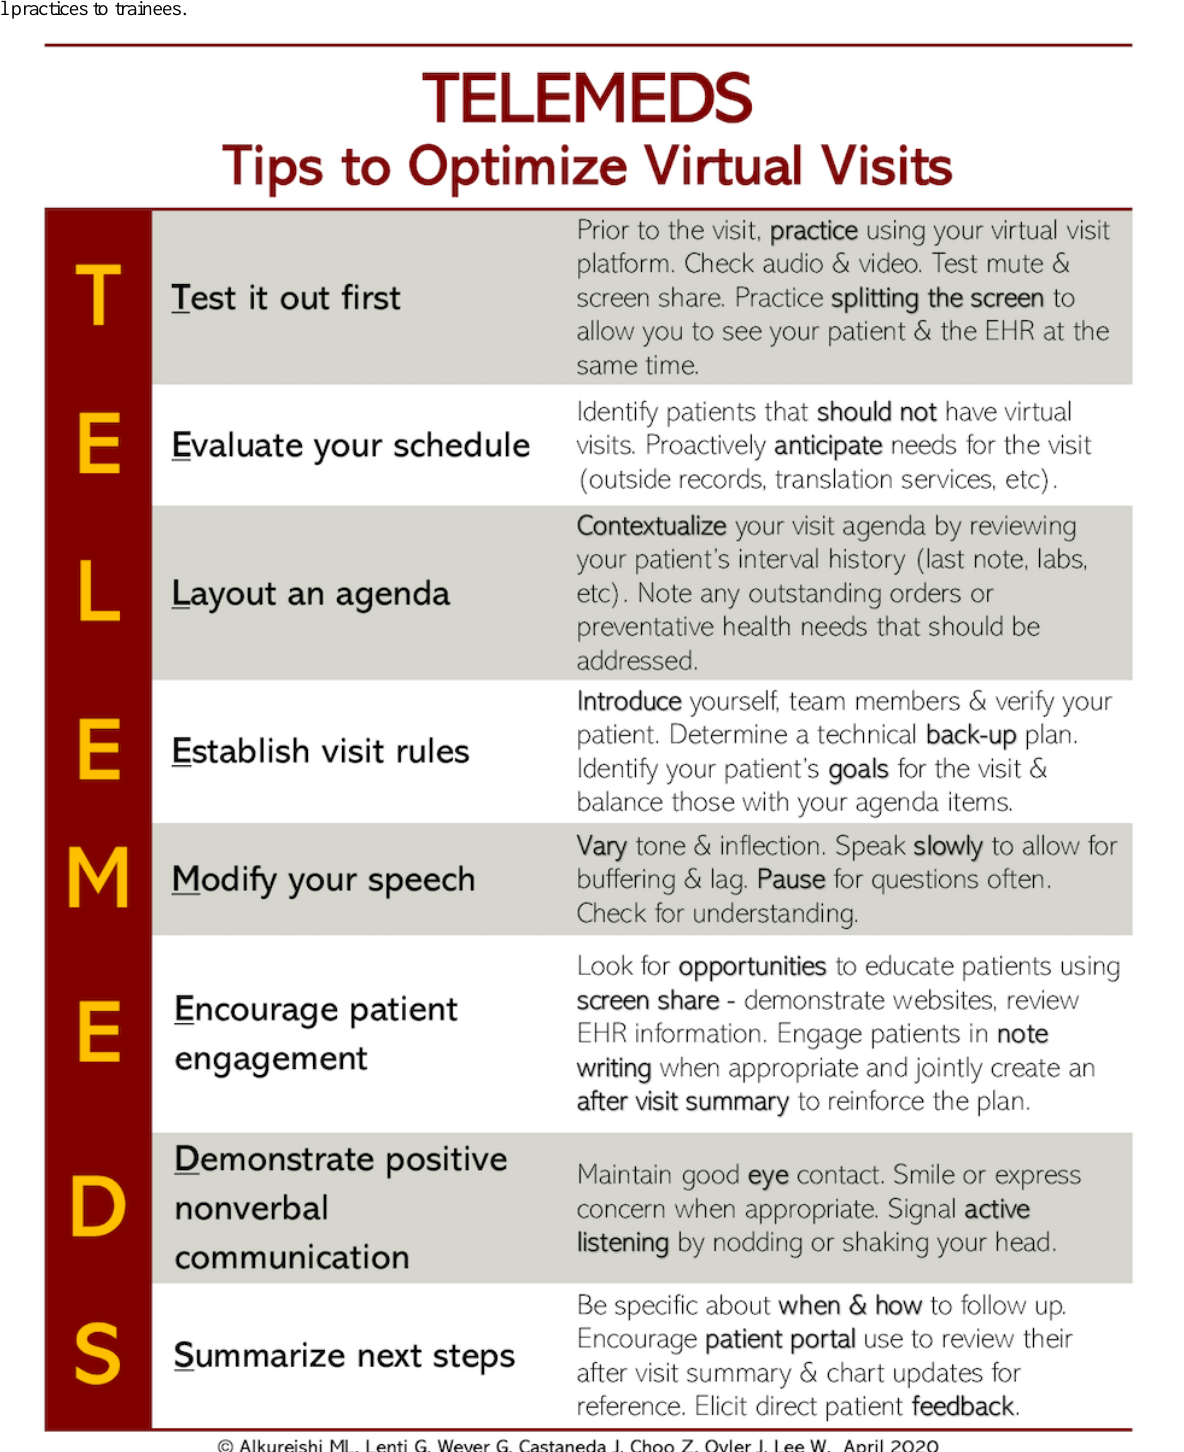
Figure 1. The TELEMEDS mnemonic, based on a literature review and input from key stakeholders, presents a framework for teaching patient-centered virtual practices to